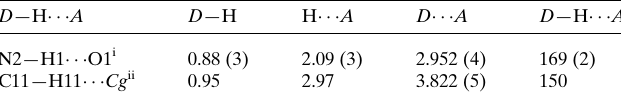
Table 1 Hydrogen-bond geometry (A˚ , (cid:2) ).